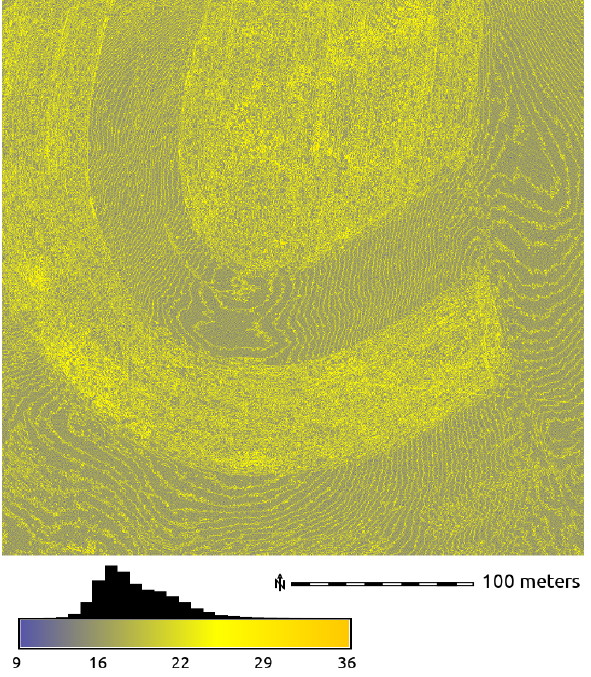
Figure 2: The number of points per cell for point cloud obtained using UAV imagery (raster resolution 0.5 m)